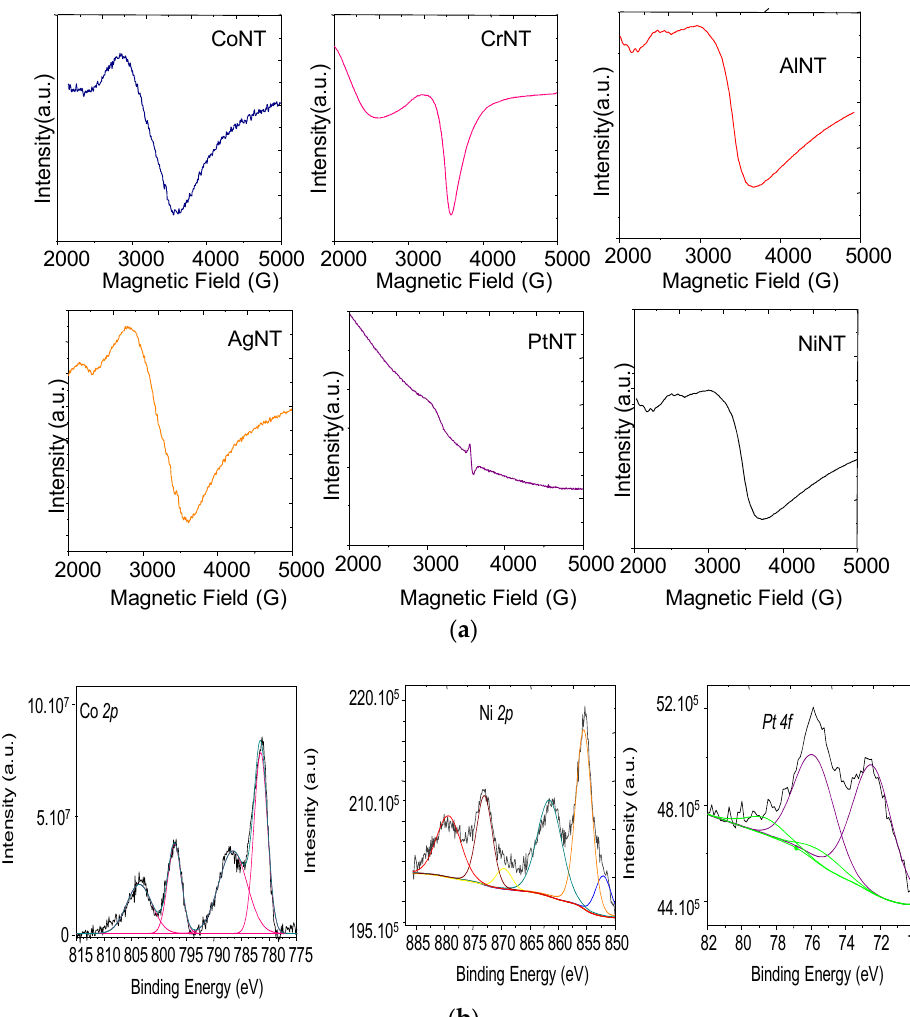
Figure 5. ( a ) EPR spectra of the studied of catalysts. ( b ) XPS spectra of the Co 2 p , Ni 2 p and Pt 4 f core level, respectively, for CoNT, NiNT and PtNT.